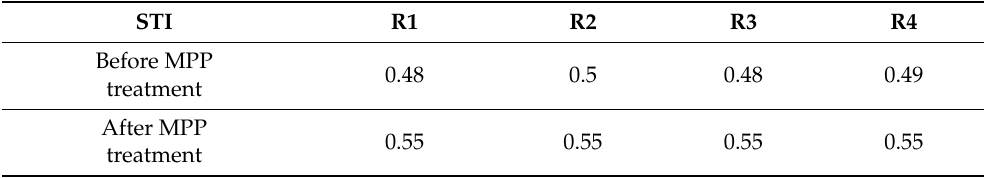
Table 6. STI values for each receiver before and after treatment. STI R1 R2 R3 Before